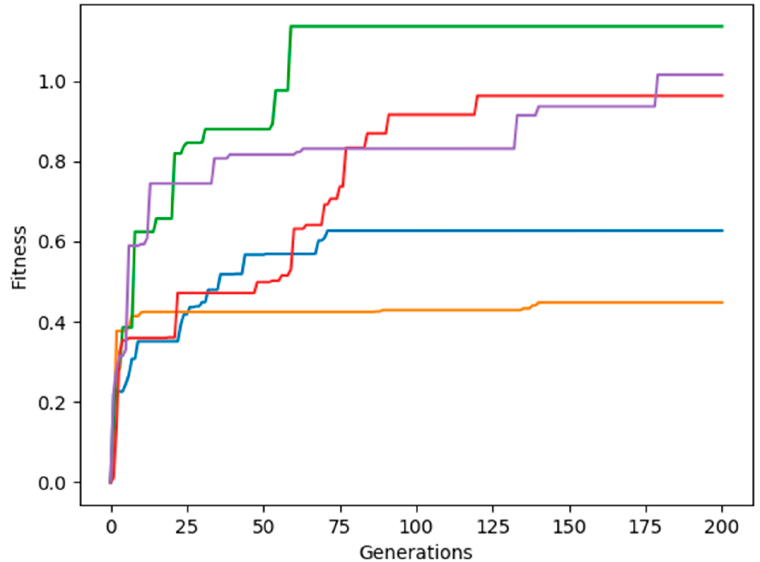
Figure 5. Adjacent joint symmetry fitness for five simulation runs, showing that the majority of the robots reached a high fitness value.